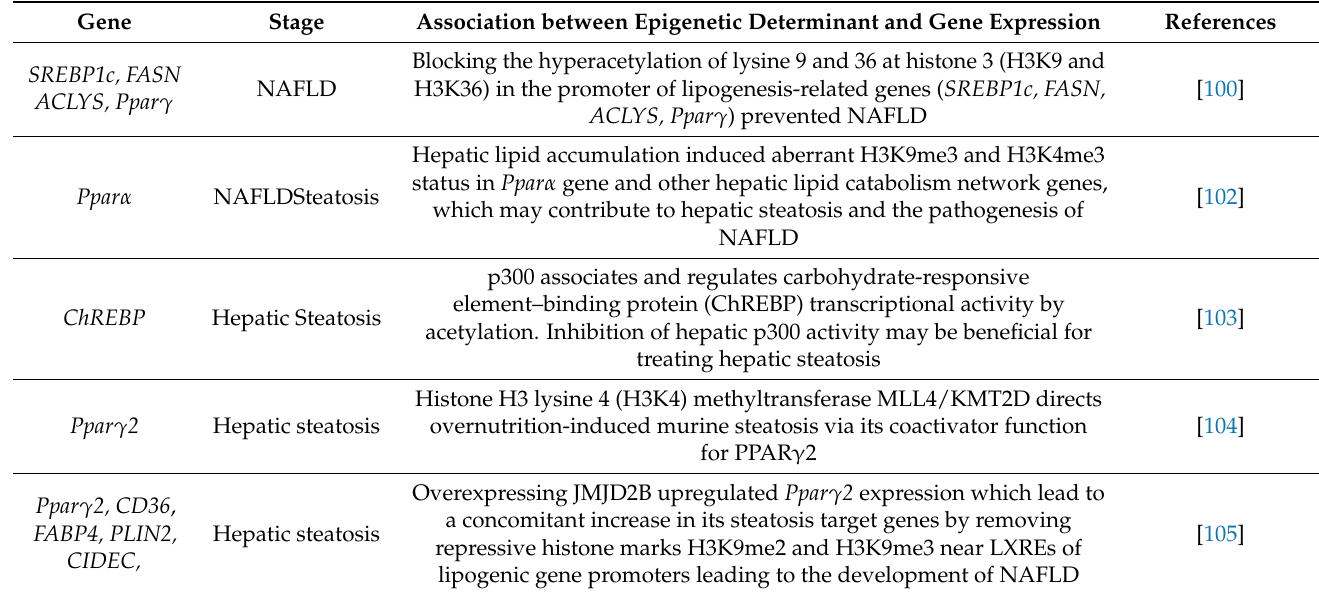
ACLY, ATP-citrate lyase; CD36, fatty acid translocase; ChREBP, carbohydrate-responsive element–binding protein; FABP4, fatty acid- binding protein 4; FASN, fatty acid synthase; HFD, high-fat diet; JMJD2B, jumonji domain-containing protein 2B histone demethylase; LXR α , liver X receptor α ; NAFLD, nonalcoholic fatty liver disease; NASH, non-alcoholic steatohepatitis; p300, transcriptional coactivator with histone acetylase activity; PPAR γ , peroxisome proliferator-activated receptor gamma; SIRT1, Sirtuin type 1;SREBP-1c, sterol regulatory element-binding protein